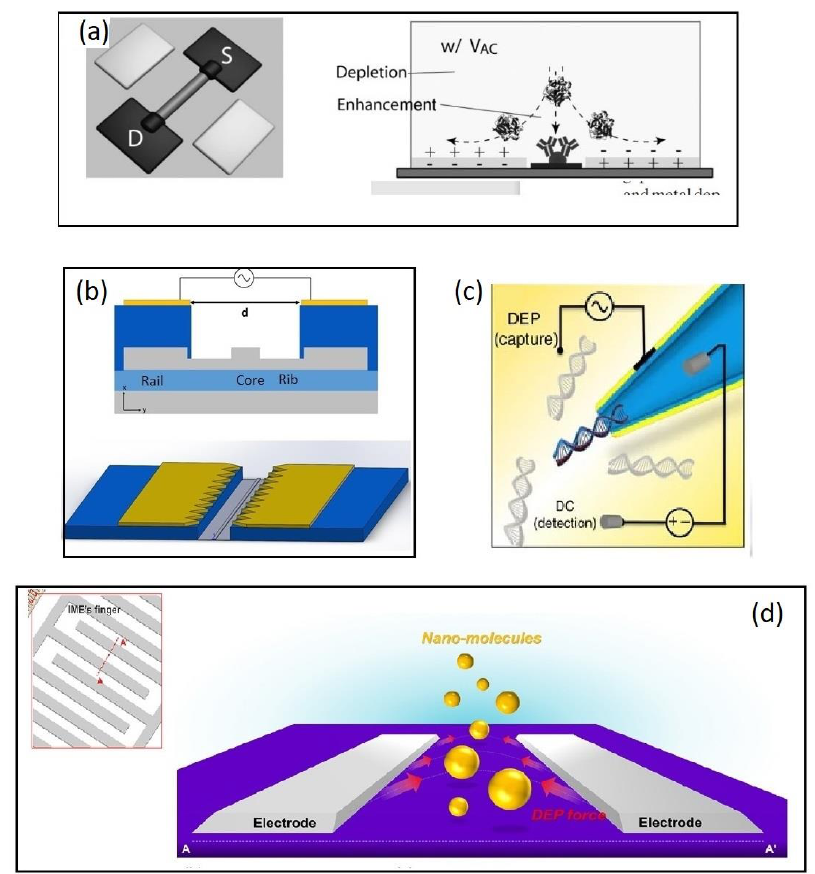
Figure 4. Examples of molecular biosensors combined with DEP for analyte enrichment. ( a ) A combination of DEP and electroosmosis enables a DEP interaction with proteins that cannot be immobilized against the electro-osmotic conveyance. Reproduced with permission [71] 2010, Wiley. ( b ) A SOI based microring resonator. The silicon waveguide (grey) is fabricated on the device layer of an SOI wafer while a coplanar electrode pair is placed on the metal 1 layer 1 um above the waveguide. Reproduced under terms of the CC-BY license Ref. [12] 2020, Henriksson et al. published by MDPI ( c ) Capillary nanopore sensor (CNP). An AC field between the metalized capillary and a planar electrode placed 20 µm away from the CNP. A separate DC field was simultaneously applied to allow the detection of DNA molecules. Reproduced under terms of the CC-BY license Ref. [79] 2016, Freedman et al. published by Nature publishing group. ( d ) A negative DEP force applied on an IDE pushes the analyte to the space between the electrode, which is functionalized with receptor molecules. Analyte capturing was monitored by impedimetric measurements. Reproduced with permission [80] 2016, Elsevier.